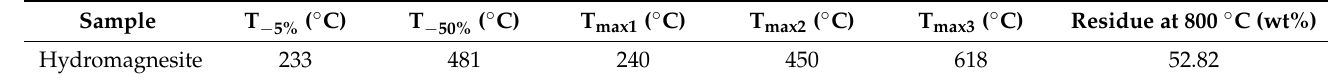
Table 2. TG data of hydromagnesite sample under nitrogen.